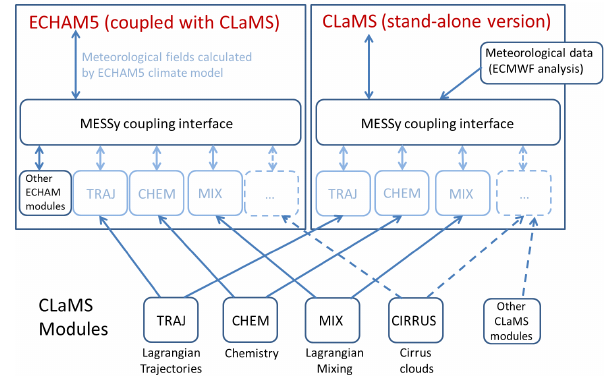
Figure 1. Schematic of the CLaMS modules integrated in the MESSy